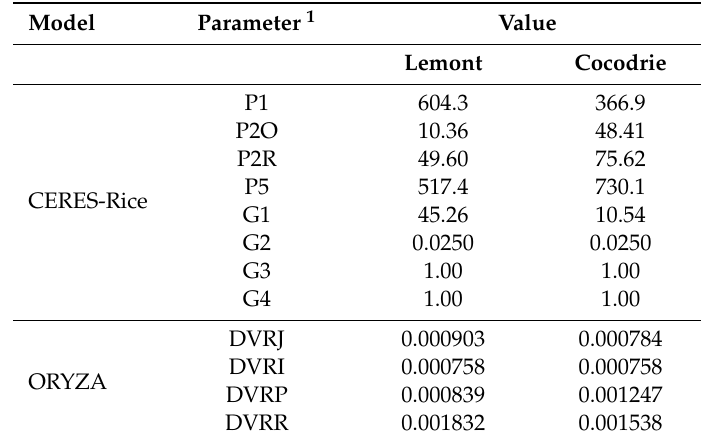
Table 3. Calibrated genetic coe ffi cient values for rice cultivars Lemont and Cocodrie in CERES-Rice and ORYZA